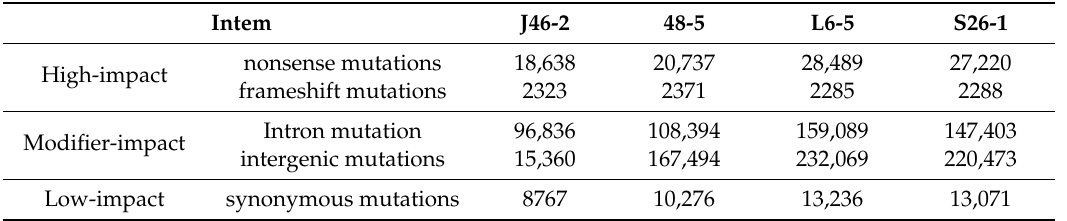
Table 4. The number of the mutations on gene function in the four ethyl methanesulfonate -induced eggplant mutants.